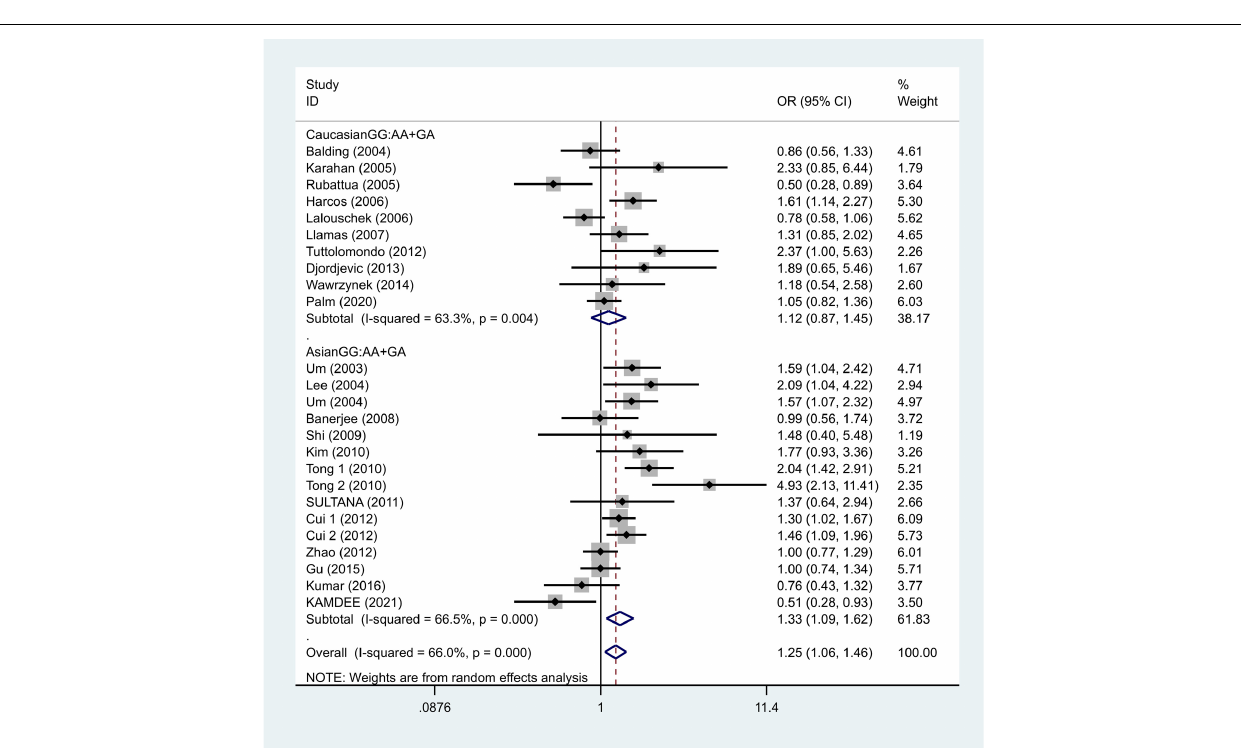
Frontiers in Aging Neuroscience |